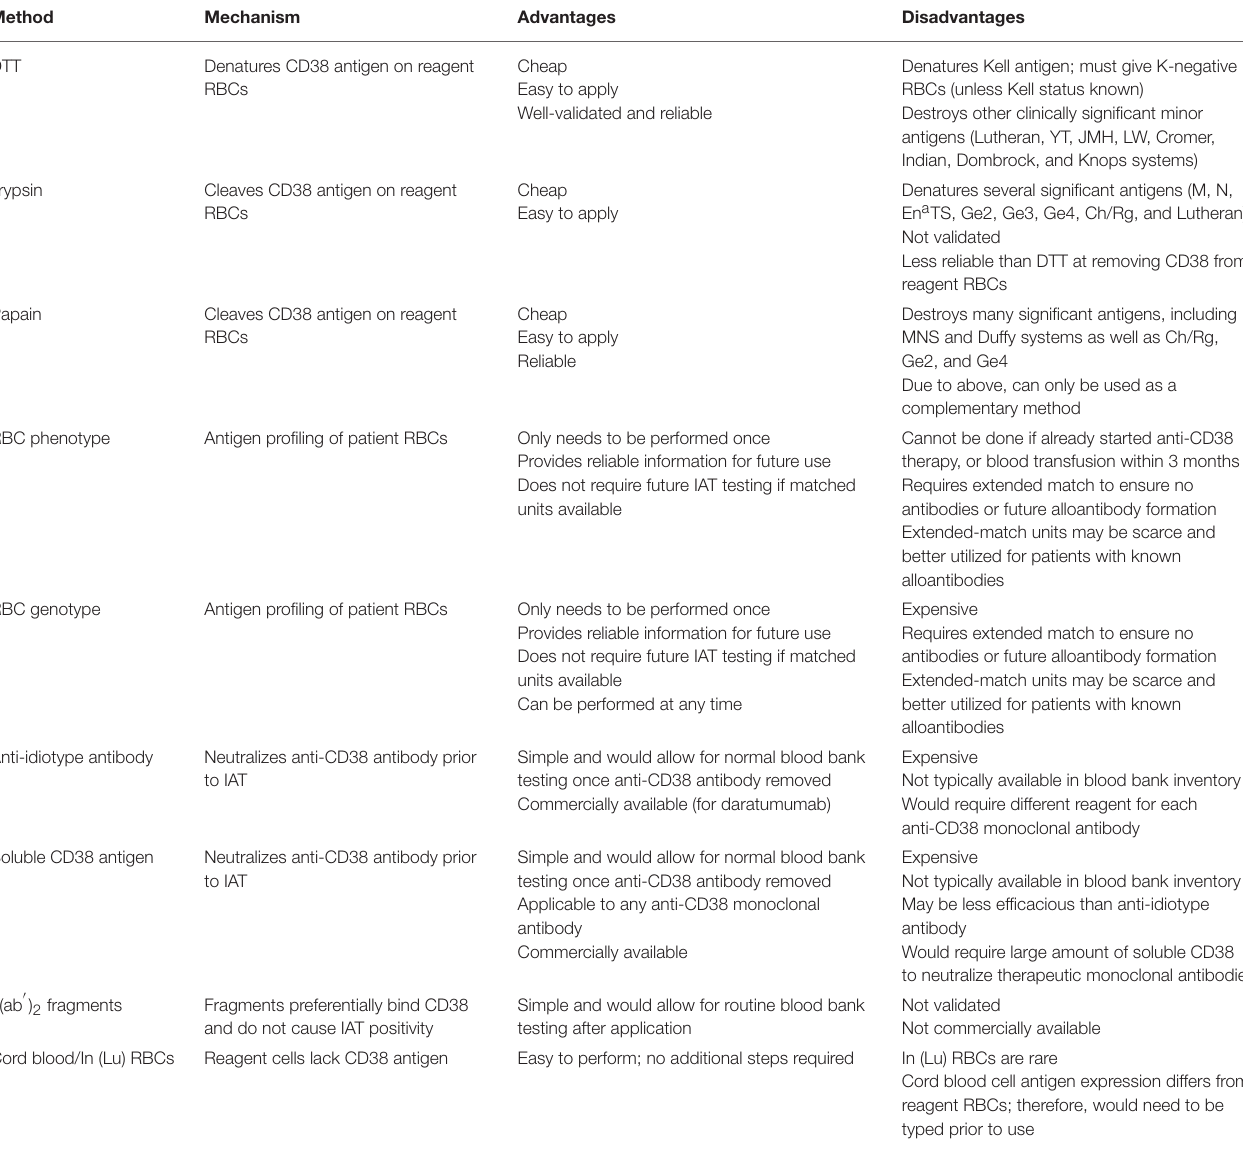
TABLE 2 | Approaches for overcoming anti-CD38 monoclonal antibody interference with IAT.